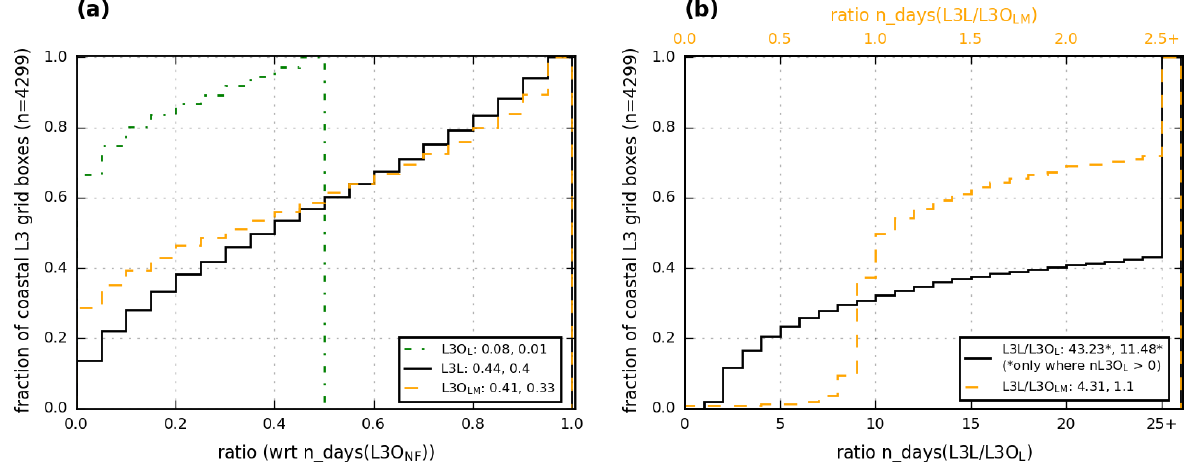
Figure 6. Cumulative-frequency histograms comparing the number of days with data for different L3O subsets and L3L at coastal L3 grid boxes. A ratio < 1 ( > 1) indicates the plotted dataset has fewer (more) days with data than the comparison dataset that is indicated on the x axis. (a) L3O L (dash-dotted green line), L3L (solid black line), and L3O LM (dashed orange line) are compared to the as-downloaded L3O dataset, without any filtering by surface index (L3O NF ). Values in the legend correspond to the mean and median ratio for the indicated dataset, respectively. Note, as a result of how coastal grid boxes are classified (outlined in Sect. 2.3), all n _days(L3O L / L3O NF ) ratios are below 0.5 (i.e. at best, L3O has a surface classification of land on 50% of days). (b) L3L is compared with L3O L (solid black line, bottom x axis) and L3O LM (dashed orange line, top x axis). Values in the legend correspond to the mean and median ratios, respectively.